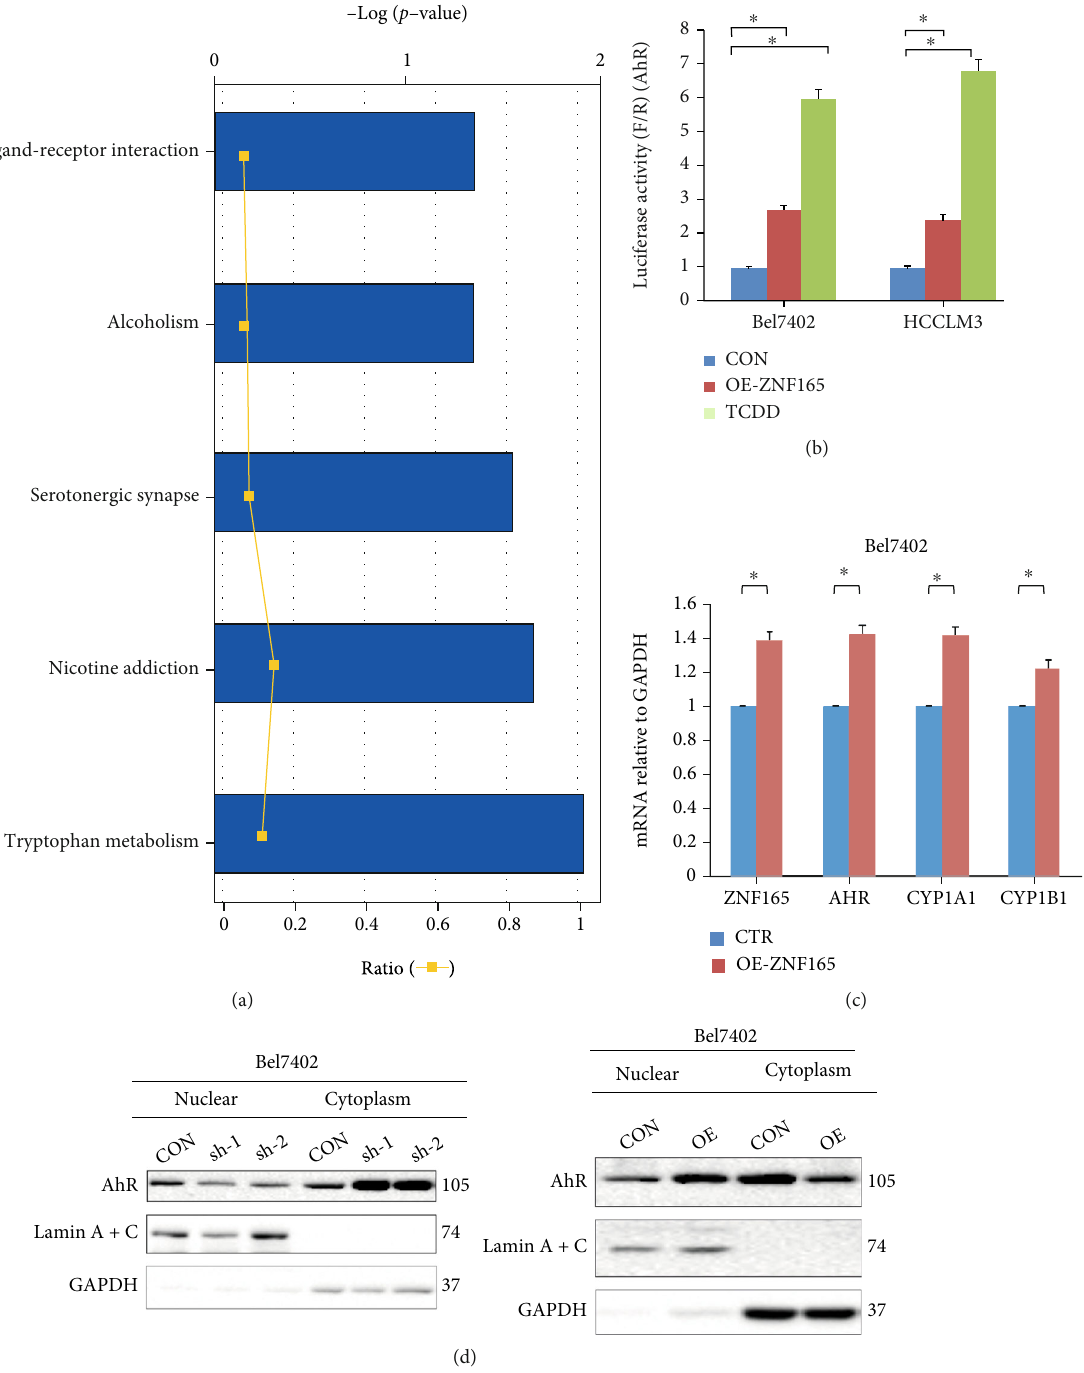
Figure 3: CYP1A1 in tryptophan signaling can be regulated by ZNF165. (a) ZNF165 knockdown was achieved in Bel7402 cells by transducing short hairpin RNA targeting ZNF165 (sh-ZNF165-1/2), and di ff erentially expressed genes (DEGs) were analyzed using array assay. DEGs were applied for signaling pathway enrichment annotation. (b, c) ZNF165 knockdown or overexpression was achieved in Bel7402 and HCCLM3 cells by transducing sh-ZNF165-1/2 or ZNF165-overexpressing plasmid (OE-ZNF165), and the mRNA expression of the tryptophan pathway-related genes AhR, CYP1A1, and CYP1B1 was determined using